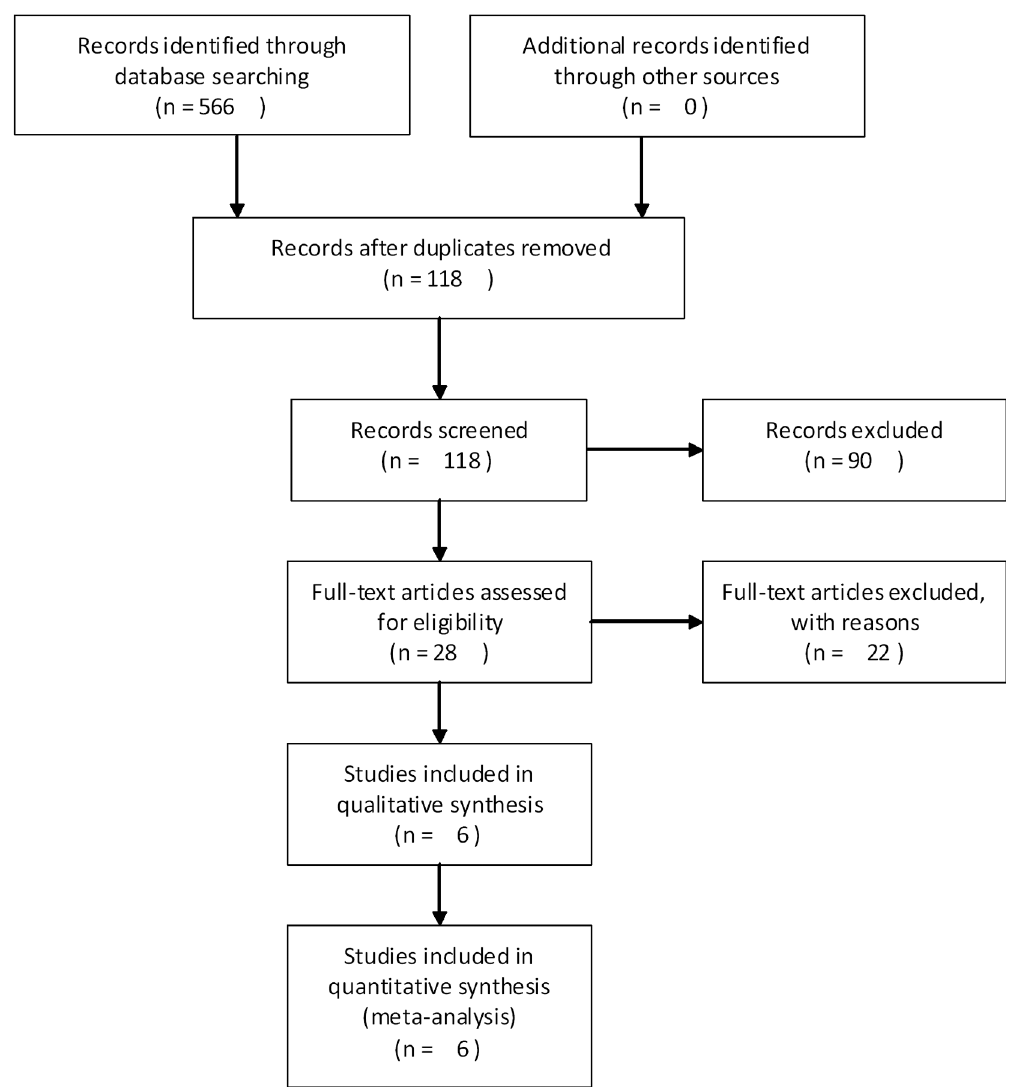
Fig 1. Flow diagram of the study selection